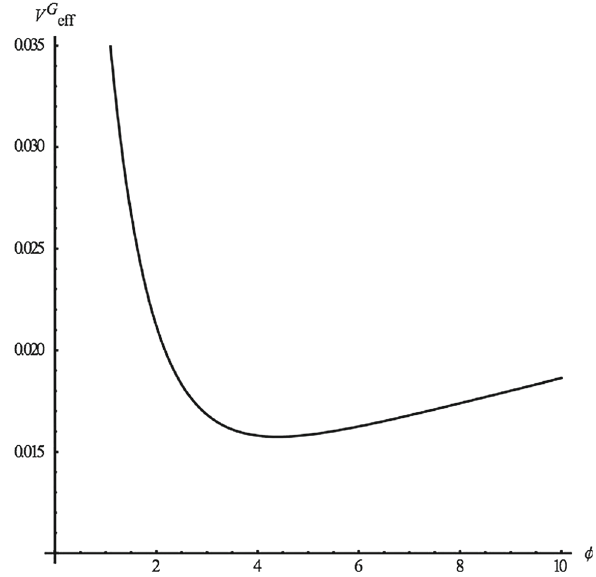
Fig. 2 Graphof V G modifiedwiththeGB-termfor M > 0.Thisgraph eff also has a minimum